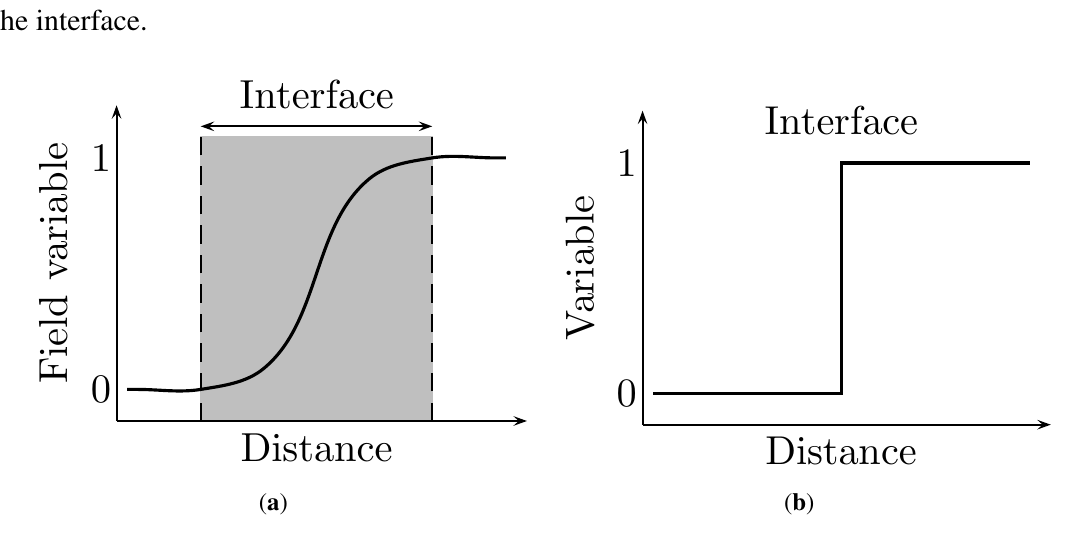
( a ) Diffuse interface description with a continuous variation of properties across the interface; ( b ) Sharp interface description with discontinuous properties across the